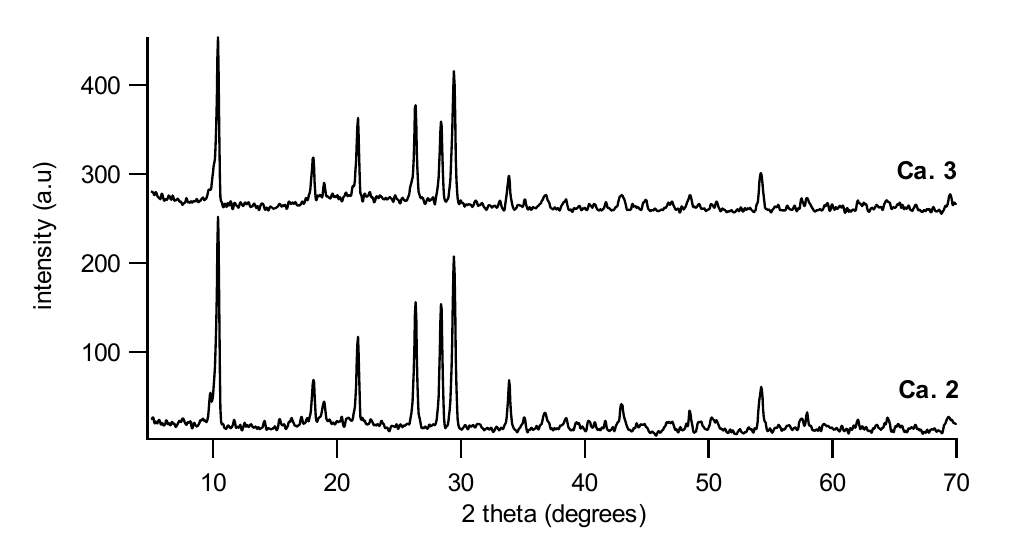
Figure 5. XRD pattern of MnO MnO –NiO–Co 2